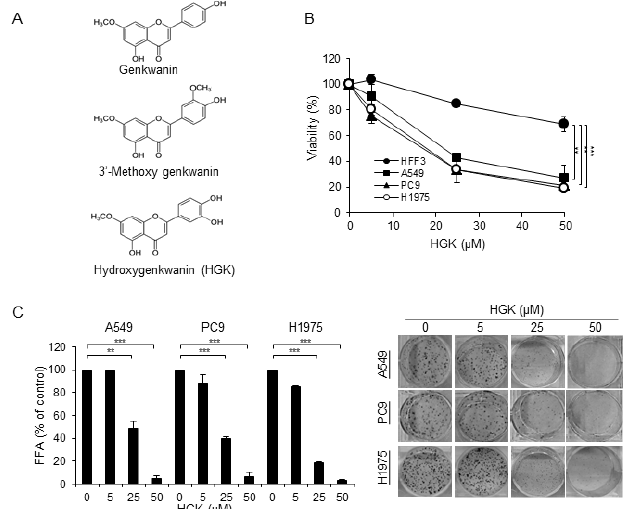
Figure 1. E ff ects of hydroxygenkwanin (HGK) on the viability of non-small cell lung cancer (NSCLC) cells. ( A ) Structures of genkwanin, 3 (cid:48) -methoxy genkwanin, and HGK. ( B ) Cells were treated with various concentrations of HGK for 24 h and the viability of treated cells was evaluated by staining with trypan blue. ( C ) Cells were treated with various concentrations of HGK for 24 h and then cultured in the absence of HGK for an additional five days. The number of foci was scored, and the data are presented as relative focus-forming ability (FFA). Data are expressed as mean ± SD of three independent experiments. ** p < 0.01; and *** p < 0.001, as analyzed with the unpaired t